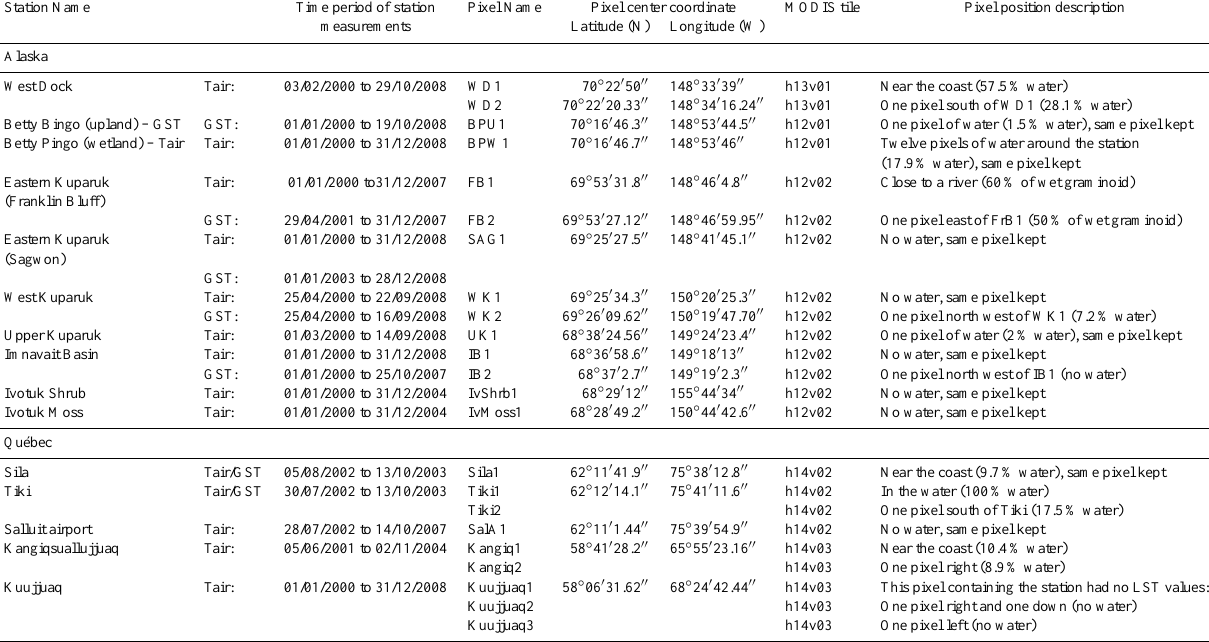
Table 2. Correspondence between stations and MODIS pixels used for comparison. Pixel description refers to the coordinates of the station within the tile and the NTDB superimposed into a Geographical Information System. % of water corresponds to the NTDB value, if it is small we kept the pixel including the station coordinates. When the percent of water is high, we took the closest pixel with less % of water. Example: For BPW, the twelve closest pixels to the station had more than 17.9% of water. As a result, we kept the pixel including the station